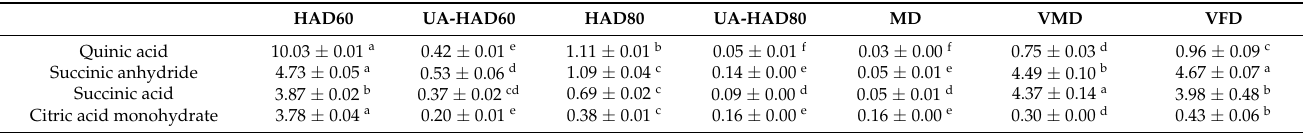
Table 3. The content of organic acids of O. raphanipes subjected to different drying methods (mg/g dry